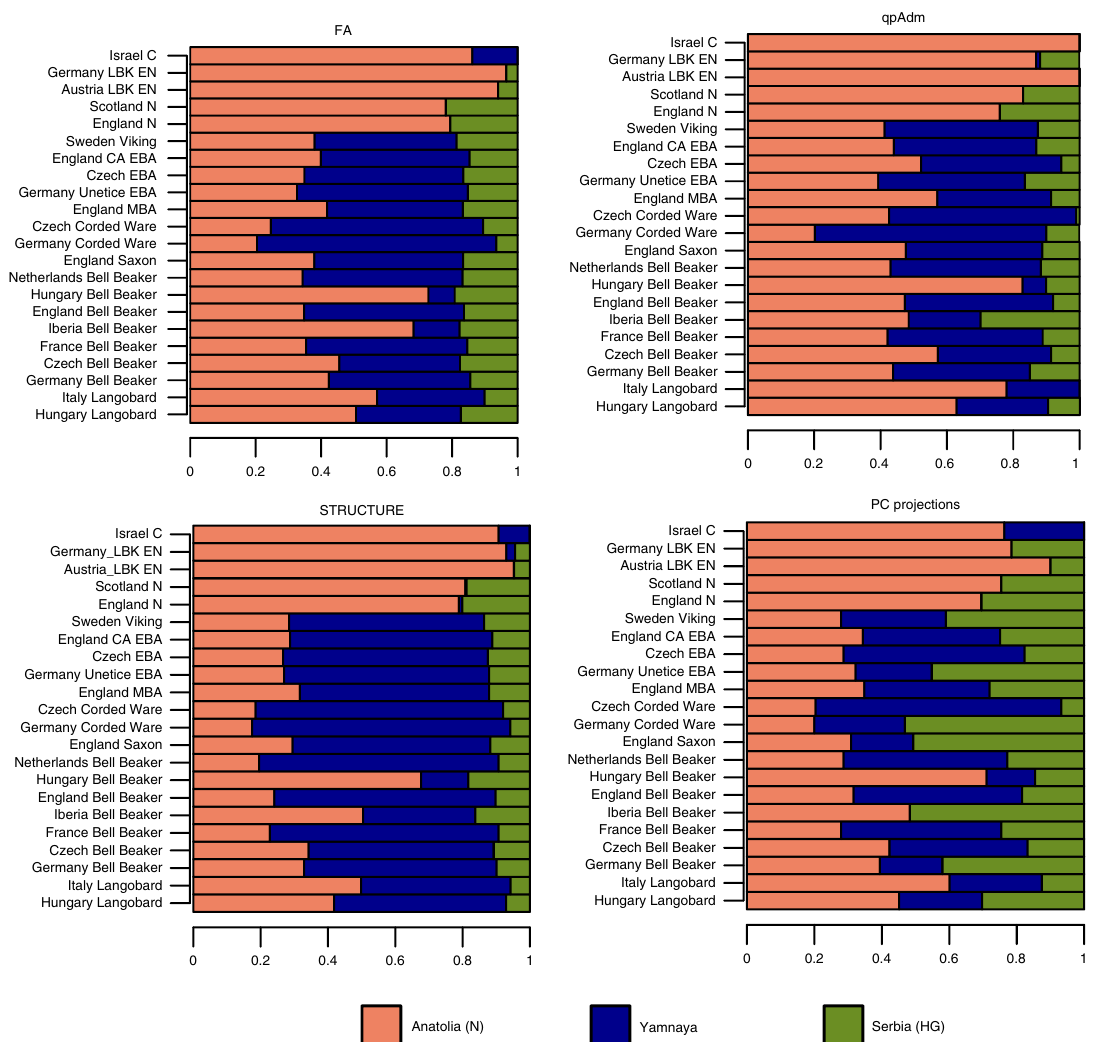
Fig. 6 Three-way admixture coef fi cients for 22 ancient population samples. Ancestry coef fi cients computed using Anatolia (N), Yamnaya Samara, and Serbia Iron Gates (HG) as ancestral populations. FA: factor analysis with λ = 0.05, qpAdm : using Yoruba, Russia Sidelkino (EHG), France-Ranchot (WHG), Aleut and Altaian samples as outgroups, STRUCTURE: implemented with sparse non-negative matrix factorization, PC projections: computed with present-day European samples from the 1000 Genomes Project. HG: Hunter-Gatherer, N: Neolithic, BA: Bronze Age, CA: Copper Age, C: Chalcolithic, E: Early, M: